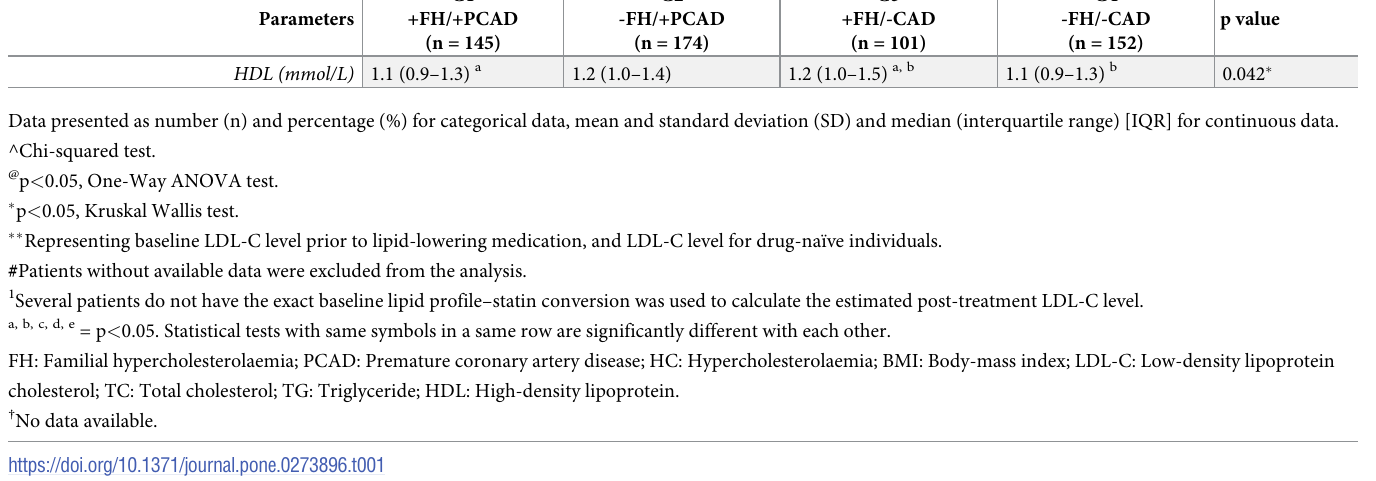
15 patients (13.8%) with corneal arcus in G1. Only one individual (2.0%) presented with TX and 42 individuals (82.4%) with corneal arcus in G3 (which were also FH). The most common risk factors among individuals with premature coronary artery disease Individuals with PCAD from G1 (n = 145) and G2 (n = 174) were combined to determine the most common risk factors among PCAD individuals. Fig 2 shows that after HC (98.1%) and